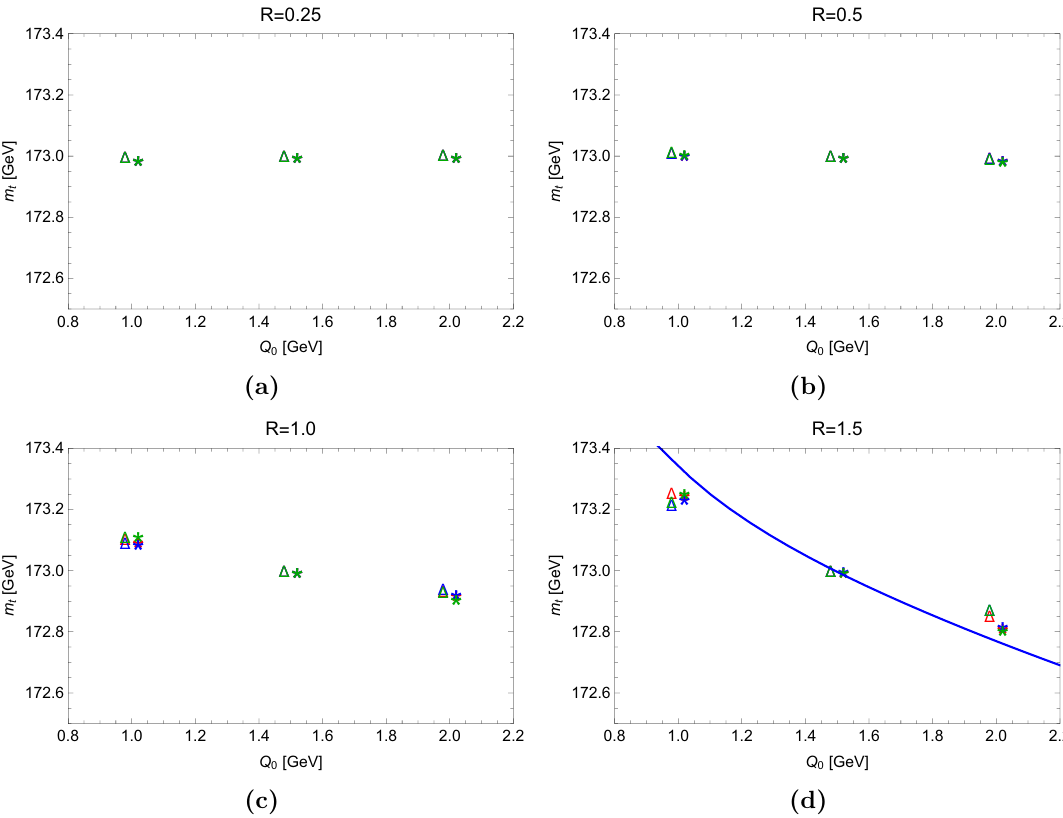
Figure 17. Fitted top quark mass as a function of the production stage shower cut Q 0 with decay stage shower cut (cid:12)xed to Q 0 ;b = 1 : 5 GeV for Q = 700 GeV obtained from the m b and the m b resonance region (triangles) using the k t -type algorithm (green), the Cambridge- j W Aachen algorithm (blue) and the anti- k t -type algorithm (red) for b -jet clustering. Displayed are the results for b -jet radii R = 0 : 25, 0 : 5, 1 : 0 and 1 : 5. The solid blue line in the lower right panel corresponds to eq. (7.5) using Q 0 = 1 : 5 as the reference 0